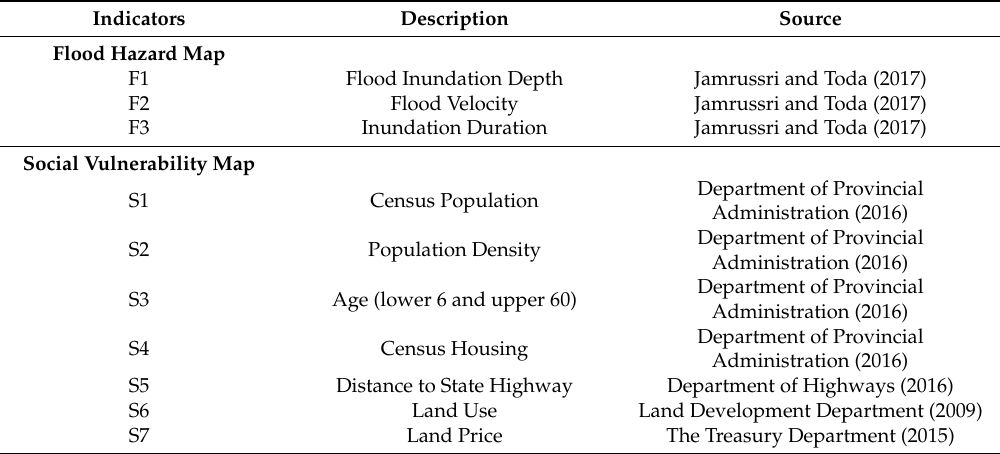
Table 1. Through standardized processing, all seven data layers in social vulnerability were converted into grid data. Table 1. Factors for the flood hazard and social vulnerability